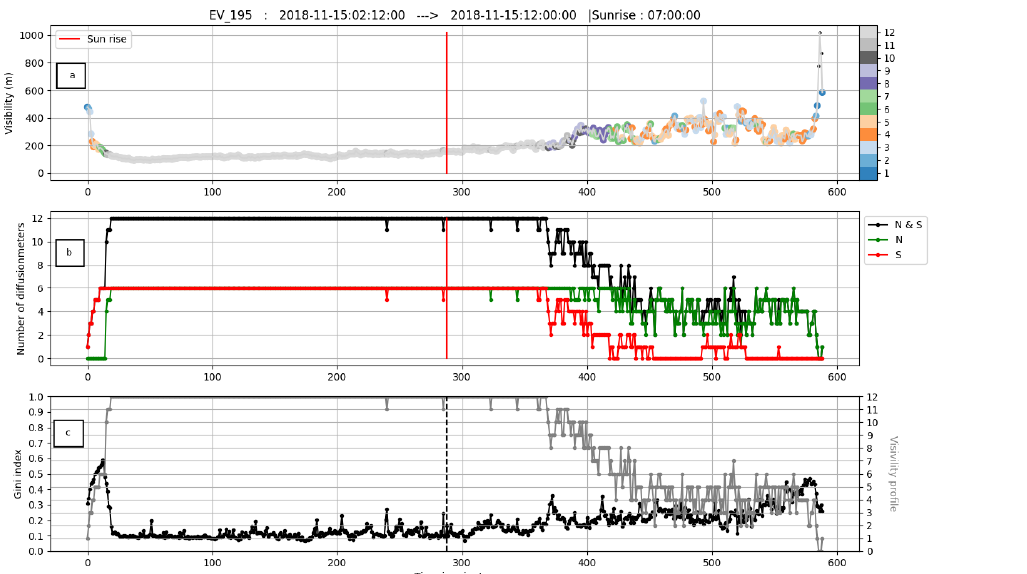
Figure 12. Example of a generalized fog event. ( a ): Time series of the minimum visibility values of the event . The colors indicate the LVU, i.e., the number of visibilities below 600m. ( b ): Time series of LVU for northern (N) and southern (S) sensors separately and altogether (N and S). ( c ): Time series of LVU in gray and Gini indexes in